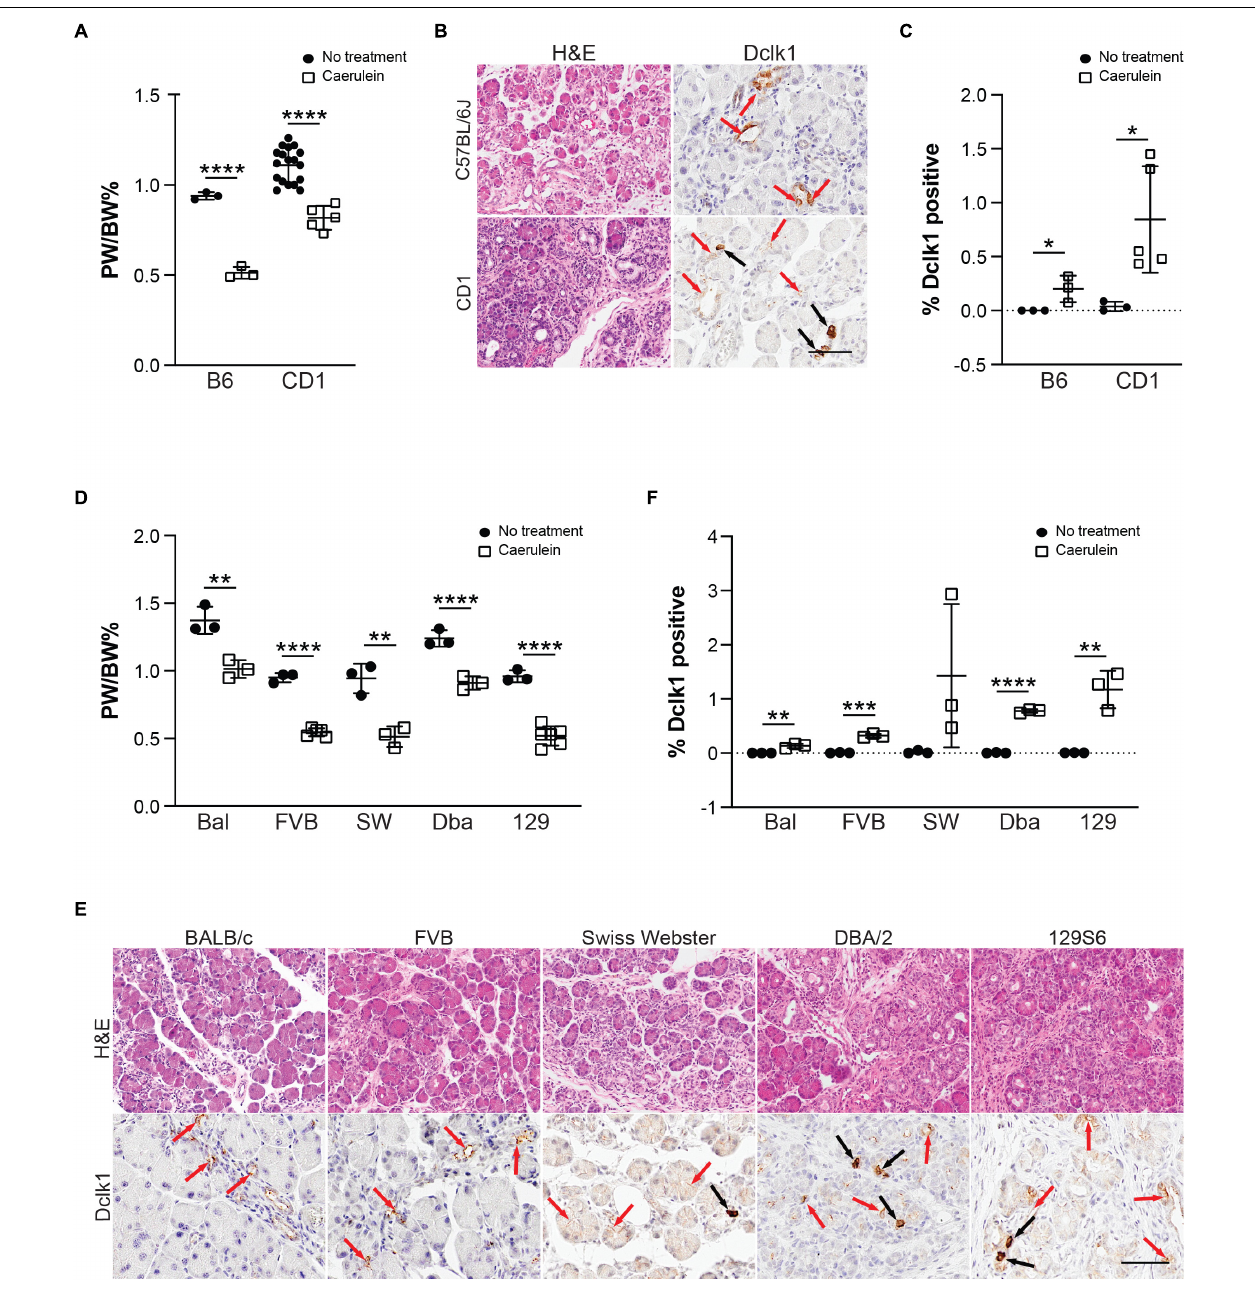
FIGURE 5 | Tuft cell formation in response to pancreatitis in wild type mice is strain-dependent. (A) Pancreas: Body weight ratio (PW/BW) changes in C57BL/6J (B6) and CD1 mice in response to four cycles of caerulein treatment. (B) H&E and IHC for tuft cell marker Dclk1 in caerulein-treated C57BL/6J and CD1 mice showing expression consistent with tuft cell morphology (black arrows) as well as non-tuft cells (red arrows), quantified in (C) . (D) Pancreas: Body weight ratio (PW/BW) changes in an additional five mouse strains in response to four cycles of caerulein treatment. (E) H&E and IHC for tuft cell marker Dclk1 in the same caerulein-treated mouse strains. Cells with tuft cell morphology (black arrows), non-tuft cells (red arrows). Dclk1 IHC quantified in (F) . Bal, BALB/c; SW, Swiss Webster; Dba, DBA/2; 129, 129S6. Scale bar, 50 µ m. * p < 0.05, ** p < 0.01; *** p < 0.005; **** p < 0.001.